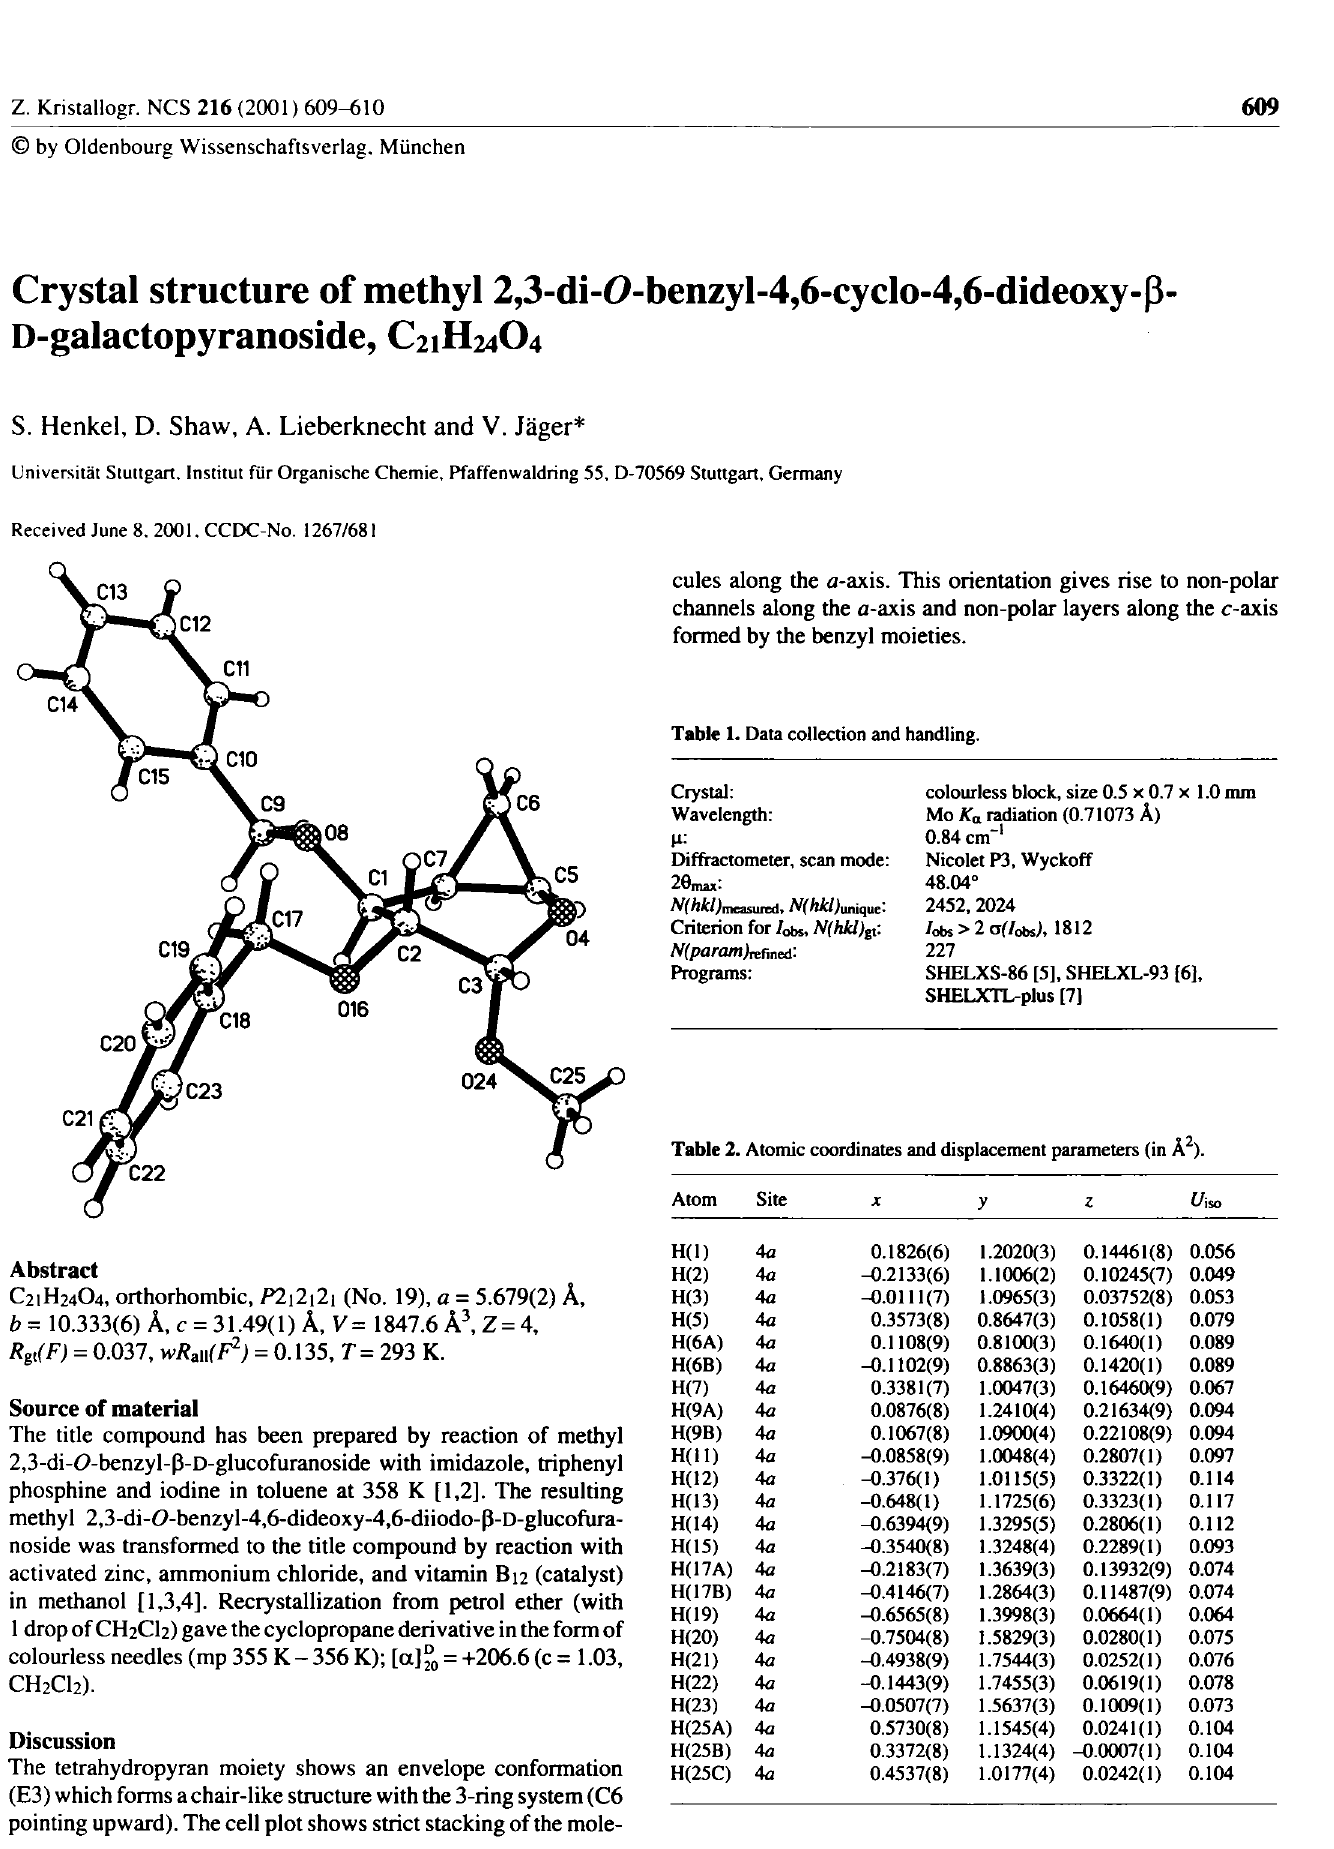
Table 2. Atomic coordinates and displacement parameters (in A 2